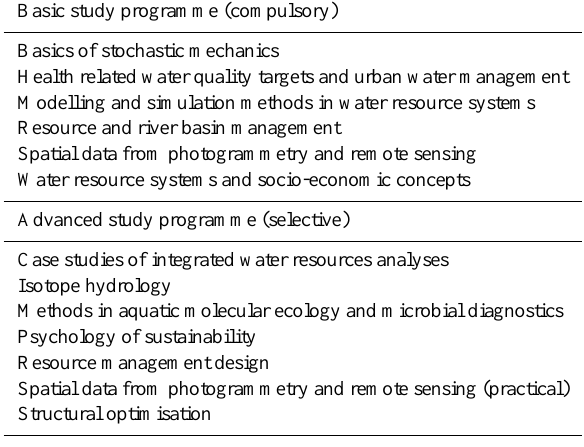
Table 2. Courses of the compulsory basic study programme and selective advanced